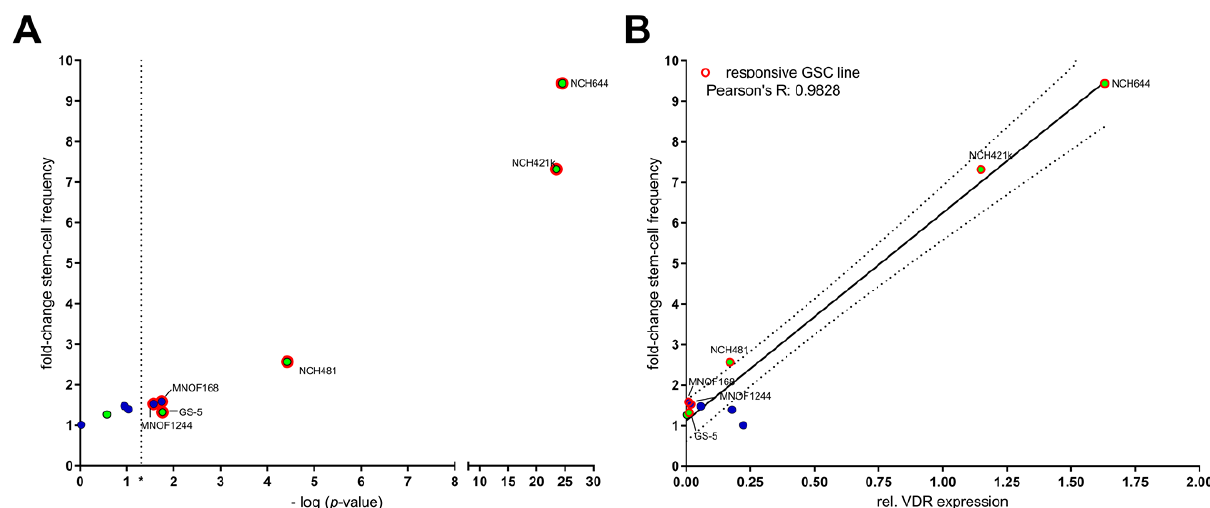
Figure 4. Differential sensitivity to calcitriol strongly correlates with VDR expression: ( A ) Point-plot of the relative fold- change in stem-cell frequency after performing a limiting dilution assay after treatment with 50 nM calcitriol or solvent for 7 days after seeding of 1024 to 8 cell per well. The stem-cell frequency was determined using ELDA [31] and the change in stem-cell frequency was calculated and plotted against the − log p -value (Chi 2 ) of the ELDA-analysis. A p -value smaller than 0.05 was considered as statistically significant is marked by the asterisk (*) on the x-axis and the dotted, vertical line. ( B ) Point-plot of the relative fold-change in stem-cell frequency as in ( A ) plotted against the relative VDR expression and Pearson correlation (black line + 95% confidence interval; dotted line). Locally established primary cultures are depicted with blue dots, non-primary cultures are depicted with green dots. GSCs with a significant reduction in stem-cell frequency (right from the dotted line in A ) are labeled and marked by red outlines in both sub-figures.